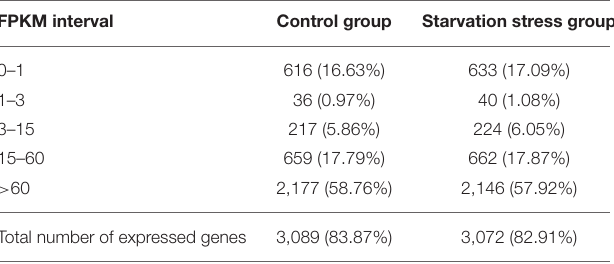
TABLE 5 | The gene coverage of RNA-seq of V. anguillarum strain BH1 before and after starvation treatment. FPKM